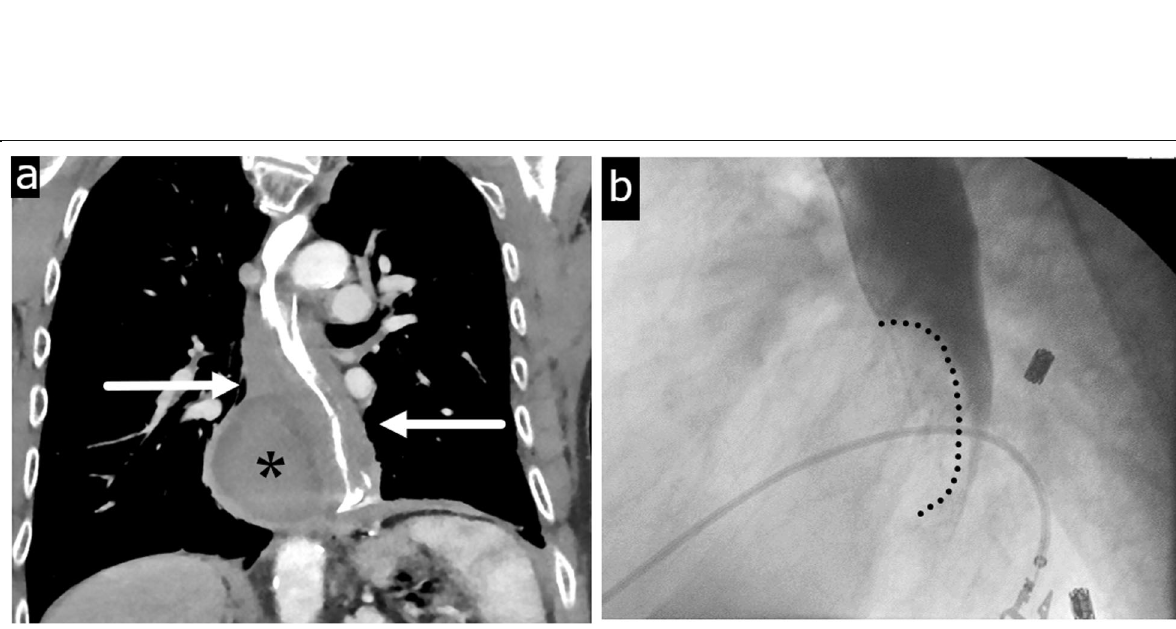
Fig. 8 Intramural hematoma. Sixty-one-year-old male with severe chest pain and dysphagia status post recent radiofrequency ablation for Barrett ’ s esophagus. a Coronal CT image shows a smoothly demarcated eccentric homogeneous intramural hematoma (asterisk) in the right wall of diffusely thick-walled esophagus (arrows). b Contrast esophagography demonstrates smoothly marginated mass effect (dotted line) on the lower esophagus by the intramural